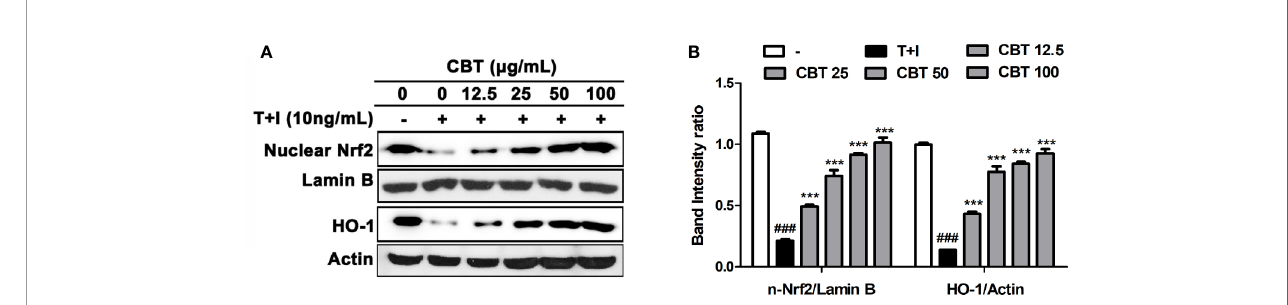
FIGURE 3 | Effects of Chijabyukpi-tang (CBT) on the nuclear Nrf2 and HO-1 proteins in TNF- a /IFN- g -stimulated HaCaT cells. HaCaT cells were pretreated with several concentrations of CBT (12.5, 25, 50, and 100 m g/ml) for 2 h and then stimulated with TNF- a /IFN- g (each 10 ng/ml) for 3 h. The proteins of nuclear Nrf2, lamin B, HO-1, and actin (A) were analyzed using western blotting. The bar graphs represent quantitative density of the bands; nuclear Nrf2/Lamin B, and HO-1/ Actin (B) . Data are shown as mean ± SEM of the three independent experiments. ### p < 0.001 compared with the no-treatment condition, ***p < 0.001 compared with the only TNF- a /IFN- g treatment